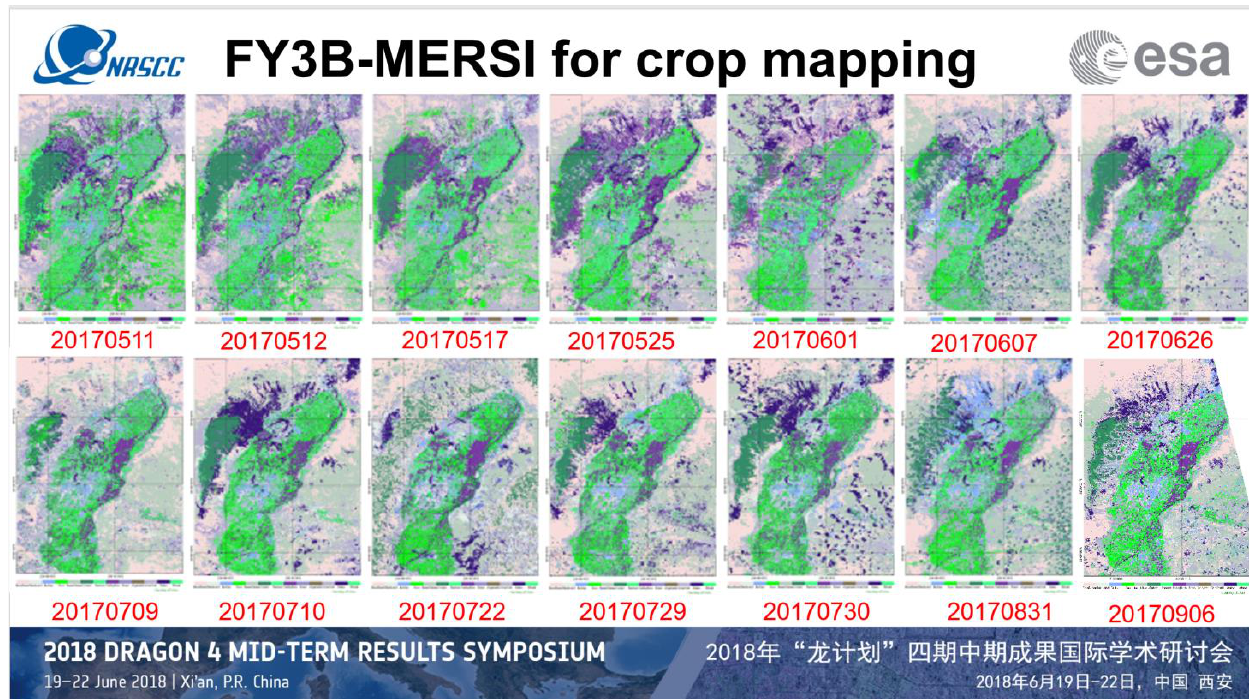
Figure 7. The accuracies of different approaches for crop type mapping. Figure 8 shows the crop maps from individual FY3B MERSI images and PROBA-V images with the approach proposed in this study.